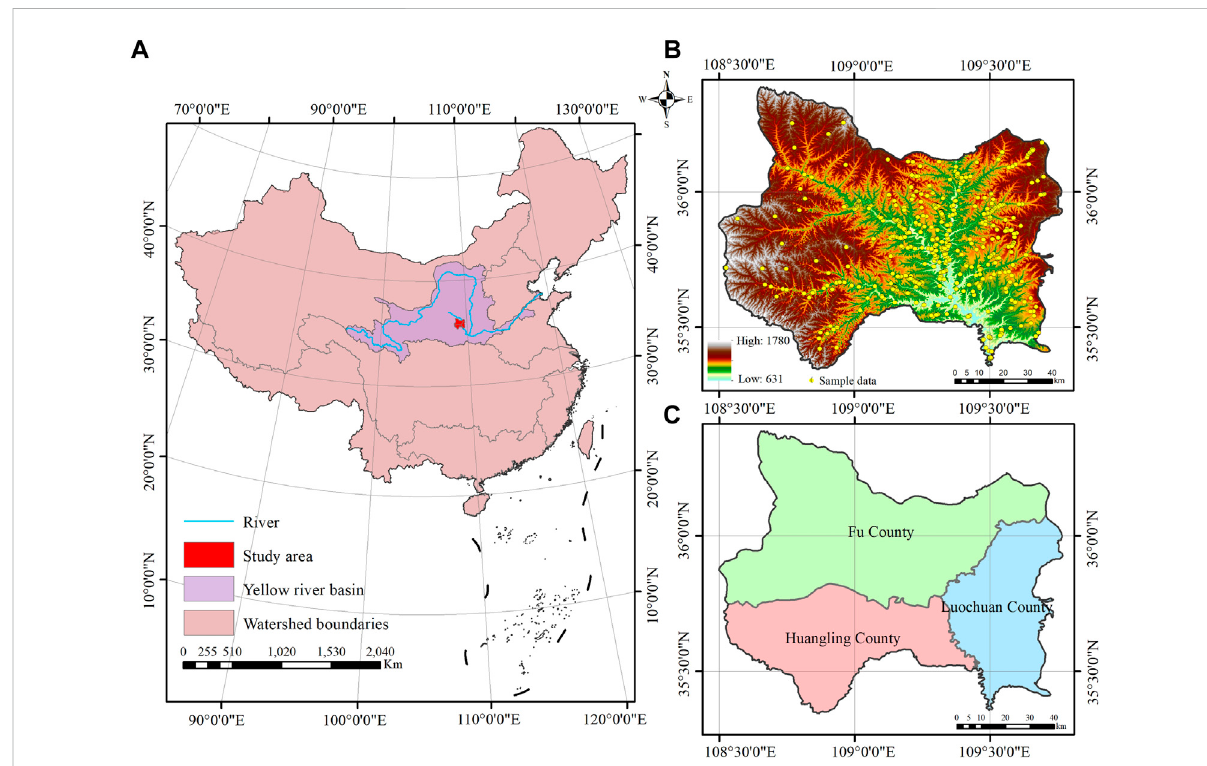
FIGURE 2 Studyarea and itsassociated information. (A) Location ofthestudy area intheLosses Plateau; (B) Topography of thestudy areaand samples on the fi eld; (C) The three typical counties in the study